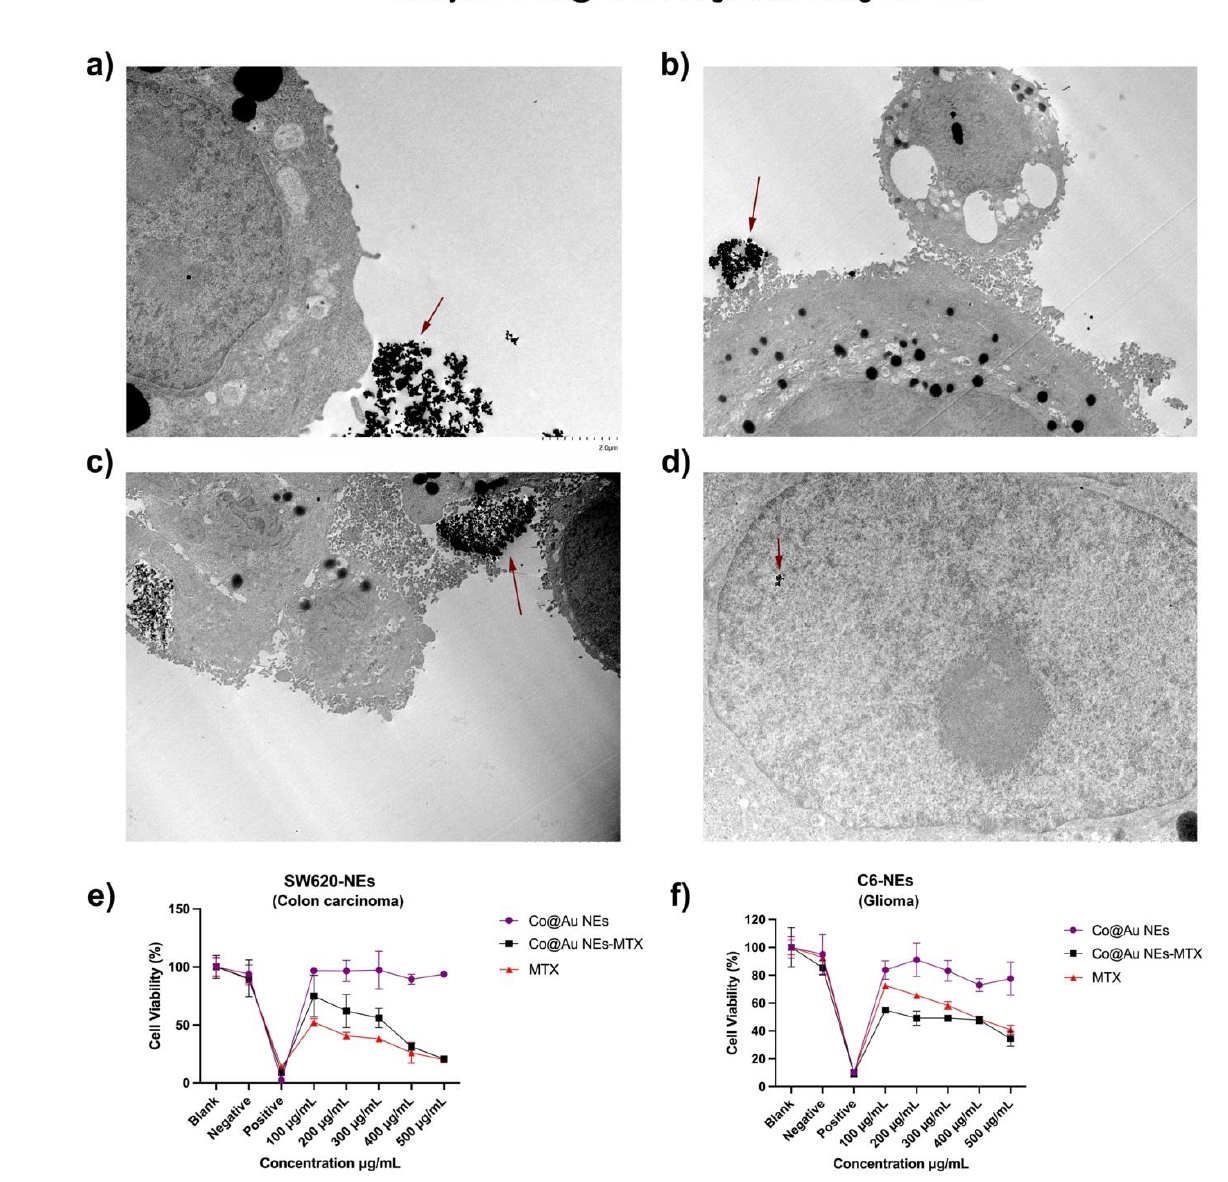
Figure 7. Analysis of elliptical Co@Au (Co@Au NEs) nanoparticle ingestion by SW620 colon carcinoma cells. ( a – d ) Bio-TEM micrographs of Co@Au NEs aggregates in SW620 cells after 12-h incubation. The scale bar in figure ( a – d ) is 2 µm. ( e , f ) Cytotoxicity of Co@Au NEs towards SW620 and C6 glioma cells, respectively. Elliptical nanoparticles displayed higher toxicity towards colon carcinoma cells. Nanoparticle clusters are represented by